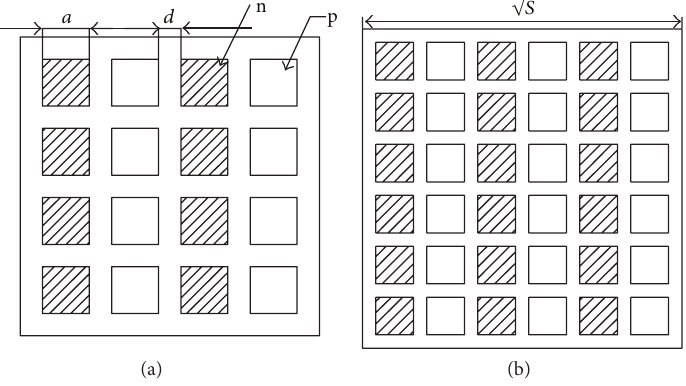
Figure 3: The top view of the TE p-n junctions array schematic